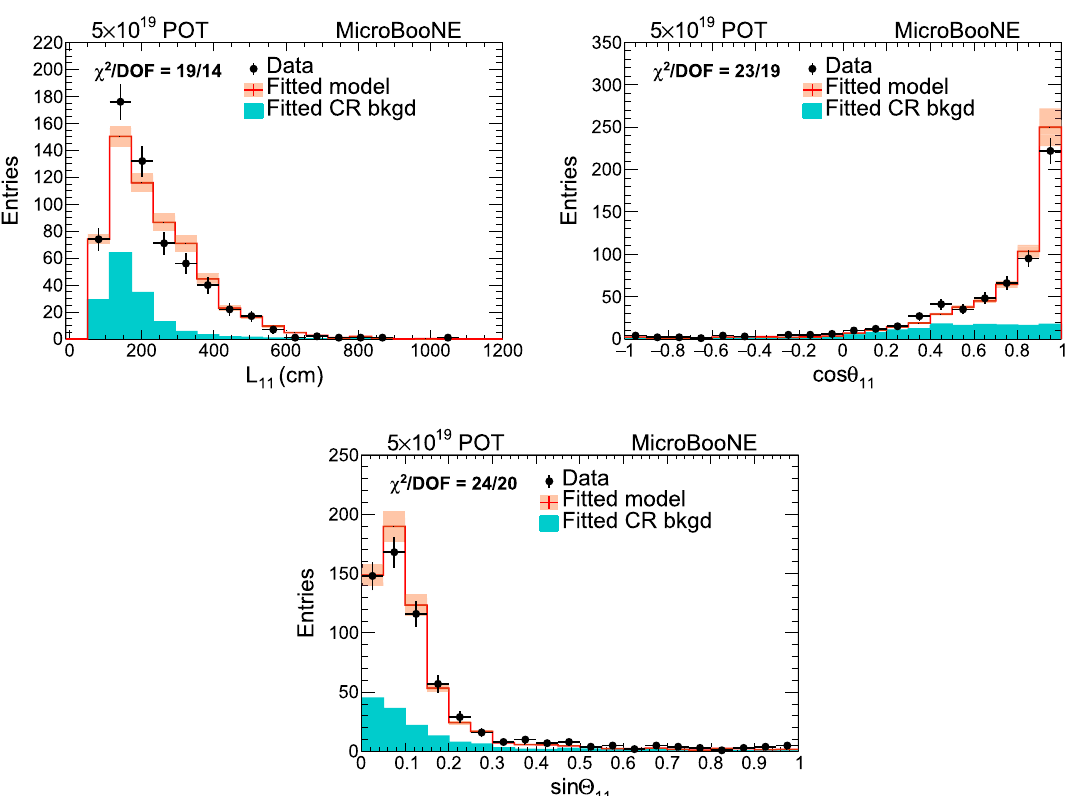
Fig. 14 Multiplicity = 1 candidate muon track length, cos θ , and sin (cid:17) distributions from neutrino-enriched sample for data and GENIE default MC